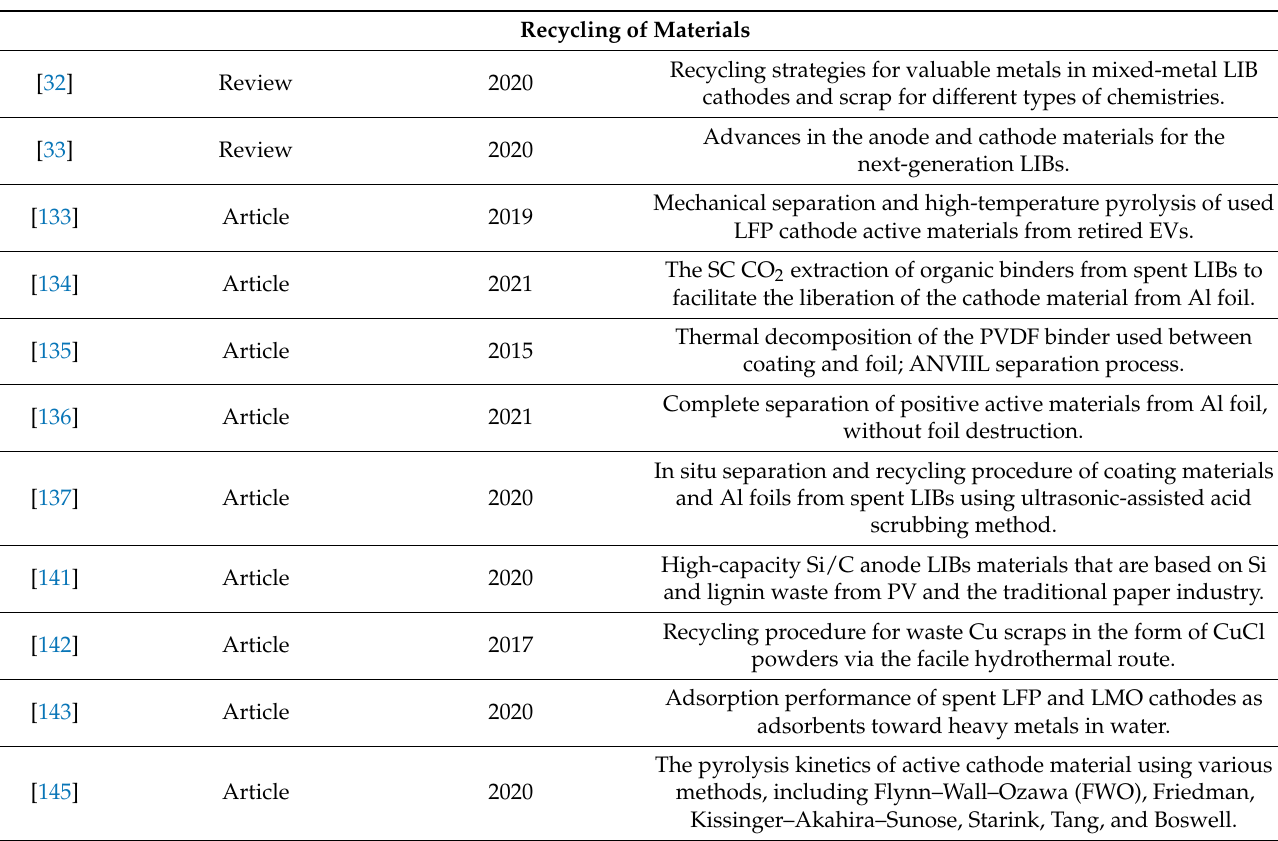
Table A5. Assessed literature in review for “Recycling of Materials”